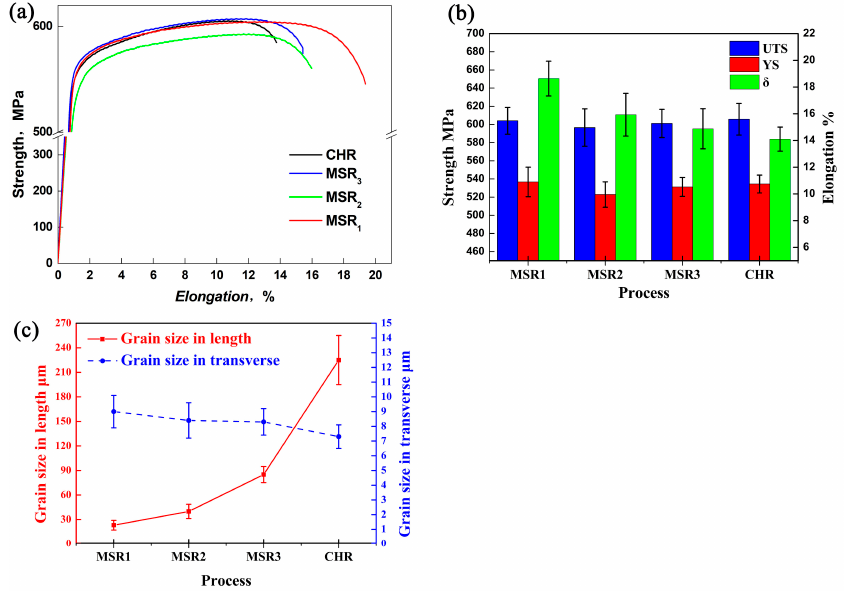
Figure 8. ( a ) Engineering stress–strain curves; ( b ) the UTS (Ultimate tensile strength), YS (yield strength) and δ (elongation) of all processed alloys after T6 aging; ( c ) the average grain size after recrystallization.